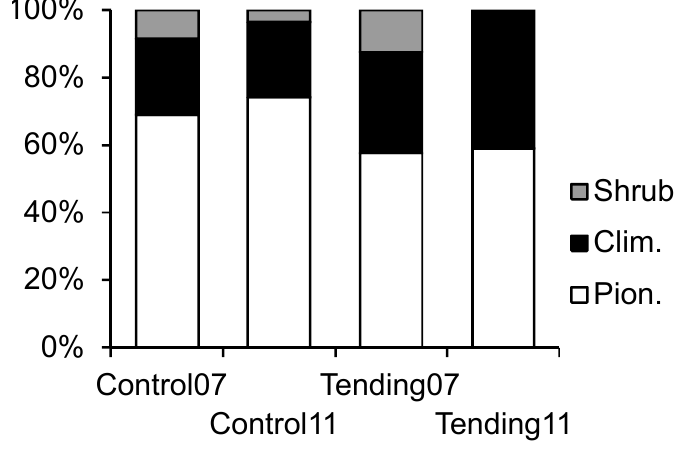
Figure A2. Species groups composition of competitors in 2007 in relation to density according to